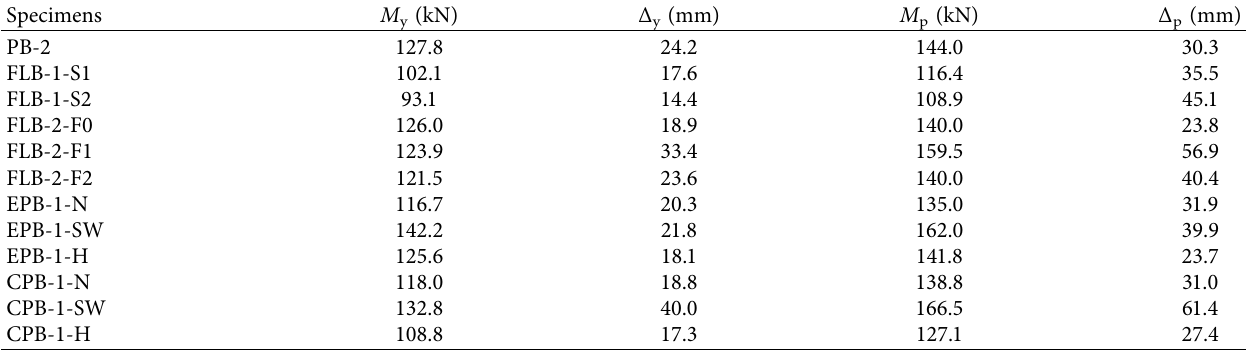
Table 3: Summary of key test